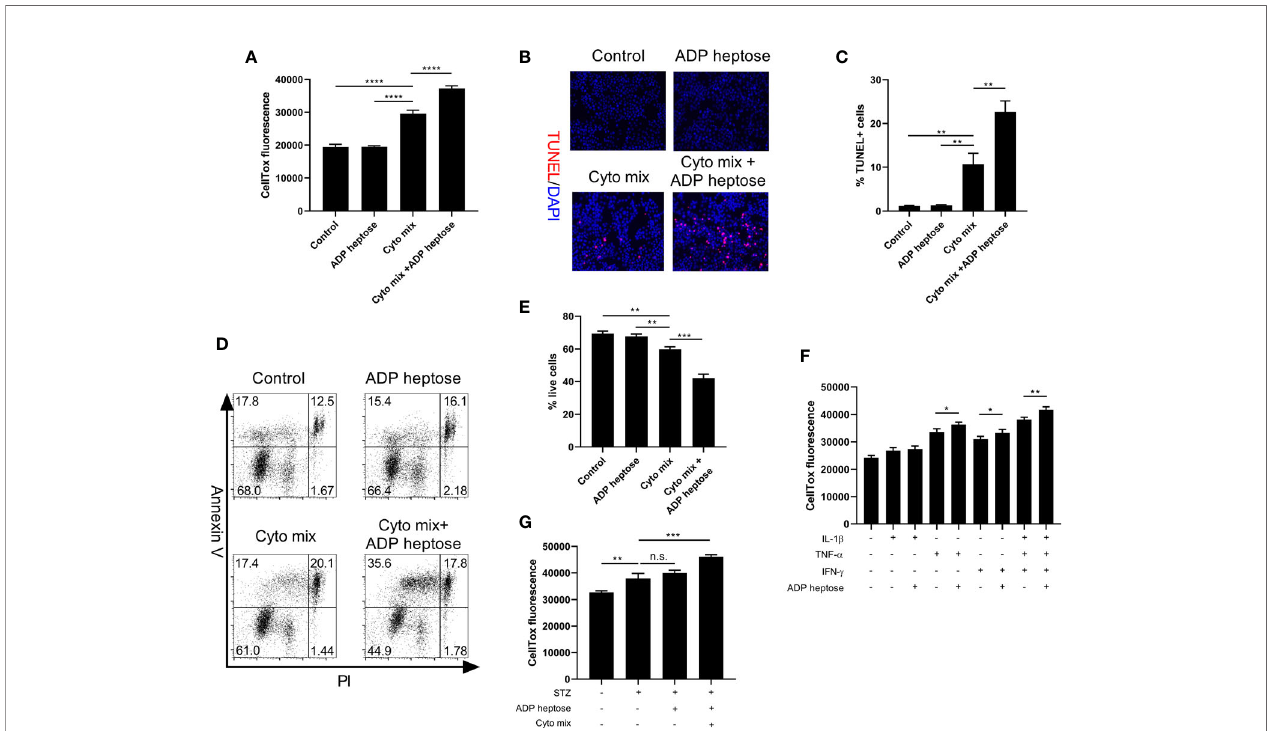
FIGURE 3 | Alpk1 activation exacerbated cytokine-induced beta cell death. 1x10 5 MIN6 cells were treated with vehicle, or ADP heptose (32 µM), or cyto mix, or cyto mix plus ADP heptose (32 µM) for 24 hours. (A) The death of MIN6 cells as assayed by the staining of CellTox Dye. (B) Representative images with at 100X magni fi cation showing apoptotic MIN6 cells (TUNEL + DAPI + ) with summary (C) . Red, TUNEL; Blue, DAPI. (D) Representative fl ow plots showing Annexin V/PI staining of MIN6 cells with summary (E) . (F) The death of MIN6 cells exposed to individual cytokine with or without ADP heptose, as assayed by the staining of CellTox Dye. (G) The death of MIN6 cells exposed to vehicle, or STZ, or STZ and ADP heptose, or STZ, ADP heptose and cyto mix, as assayed by the staining of CellTox Dye. Data show mean ± SD and are representative of 3 independent experiments. Data were analyzed with unpaired Student ’ s t-test. **P < 0.01; ***P <